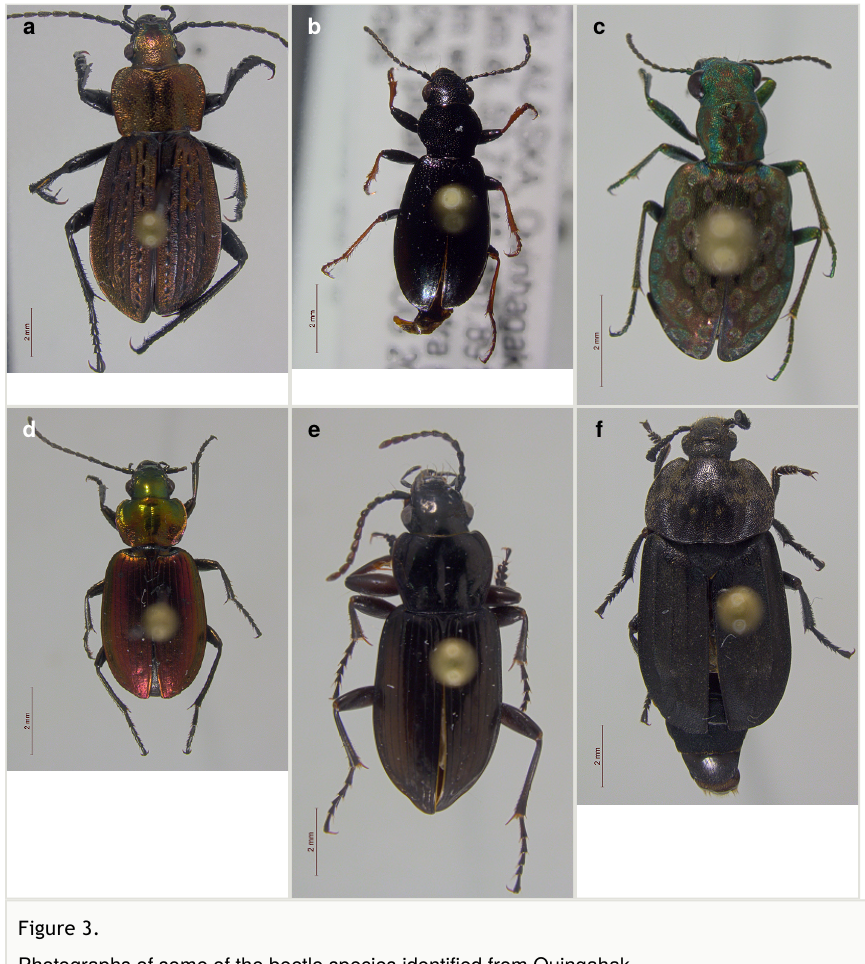
Photographs of some of the beetle species identi fi ed from